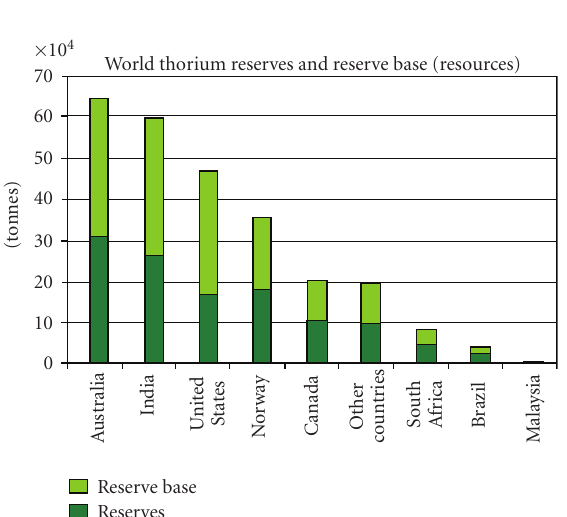
Figure 2: Thorium Deposits in the World [5].